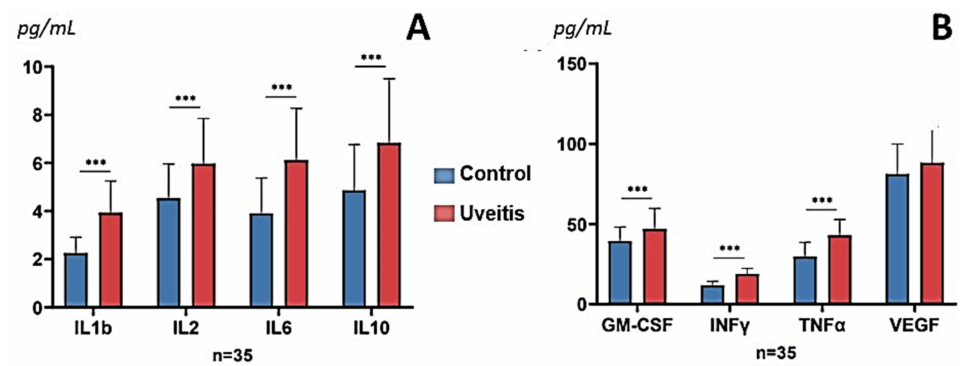
Figure 5. Plasma levels of pro-inflammatory mediators in the main groups of the study participants. Results show mean (standard deviation). ( A ) Interleukines. ( B ) Other cytokines. IL: interleukin; GM-CSF: granulocite macrophages colony stimulating factor; INF- γ : interferon gamma; TNF-a: tumor necrosis factor alpha; VEGF: vascular endothelial growth factor. Statistically significant *** = p <